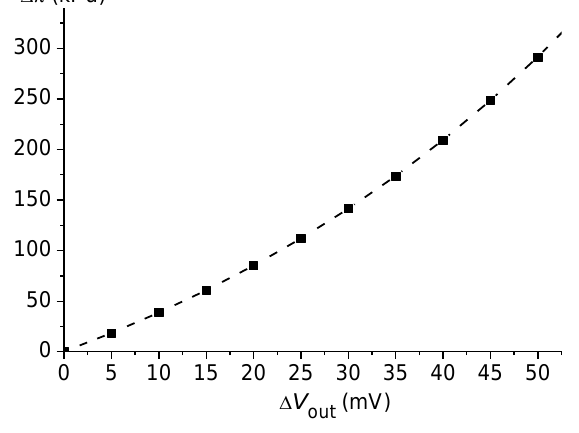
) of the piezoresistive chemomechanical out